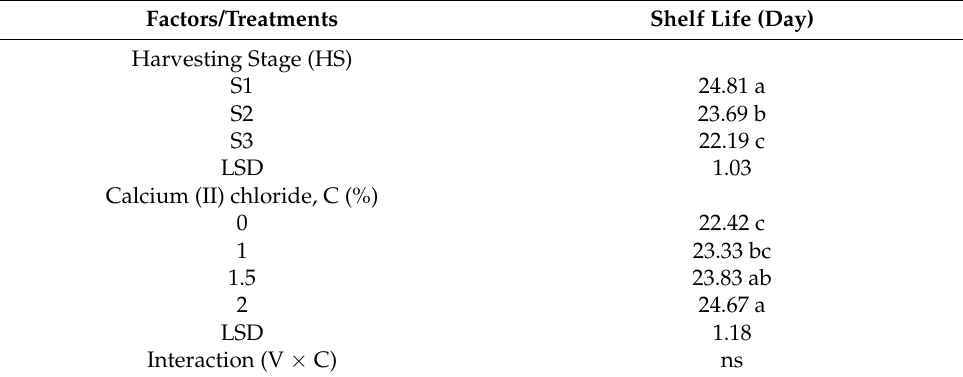
Table 4. Main interaction effects of harvesting stages (mature green S1, breaker S2, and half ripe